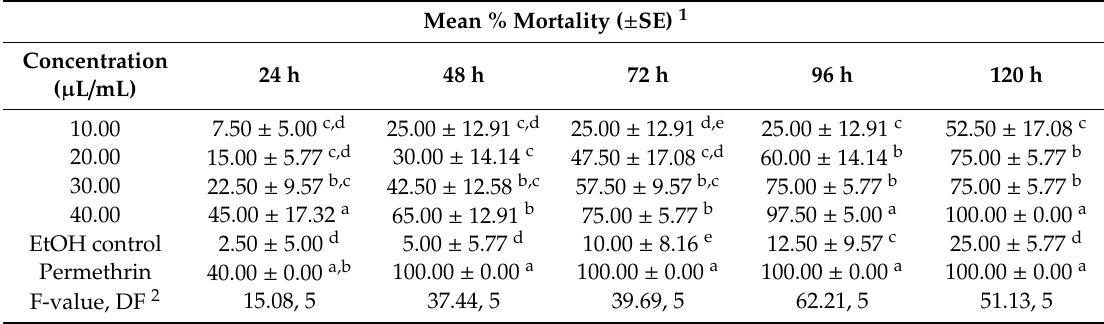
Table 2. Contact insecticidal e ff ects of Launaea taraxacifolia essential oil on adult mortality of Sitophilus oryzae reared on rice grains 120 h after